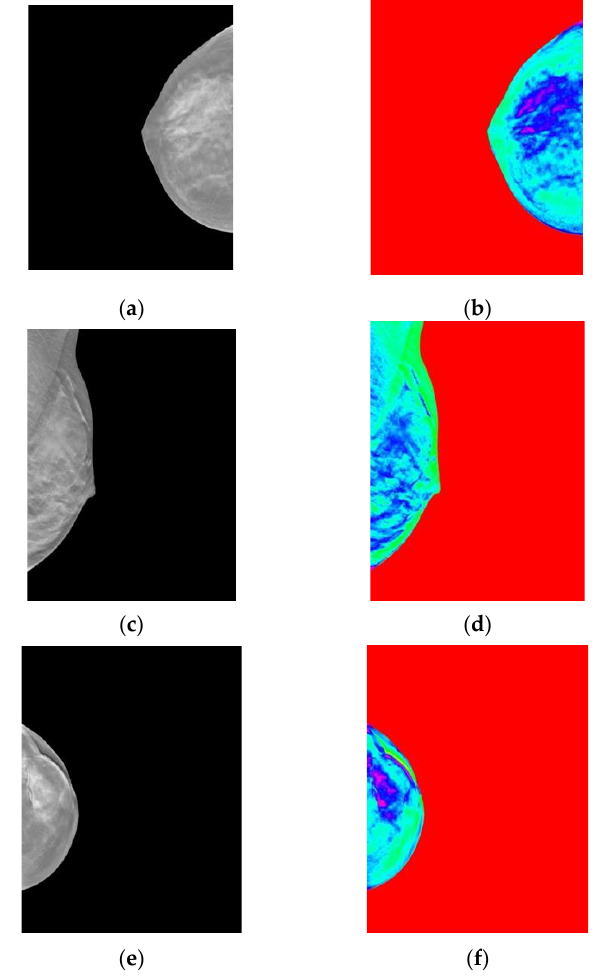
Figure 3. Samples of colour mapping ( a ) original normal image, ( b ) colour mapped normal image, ( c ) original benign image, ( d ) colour mapped benign image, ( e ) original malignant image, ( f ) colour mapped malignant image.